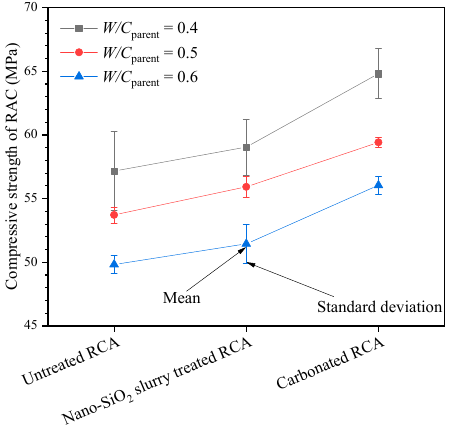
ff erent types of